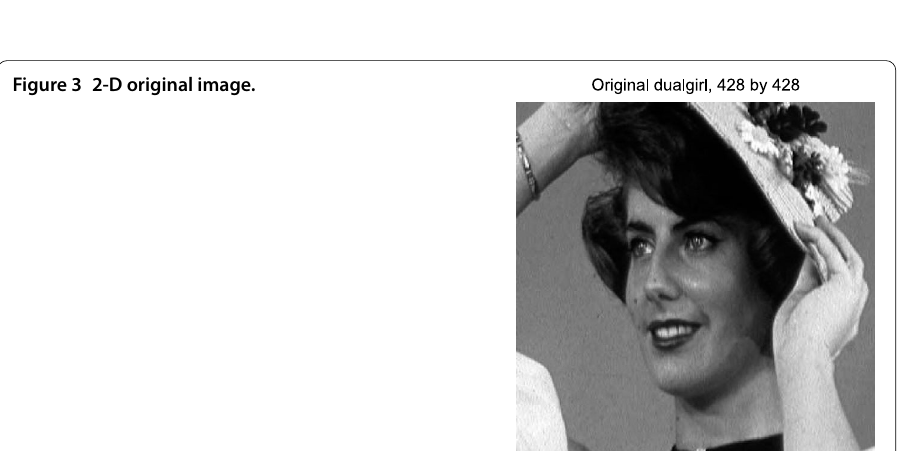
Figure 2 1-D denoising results.